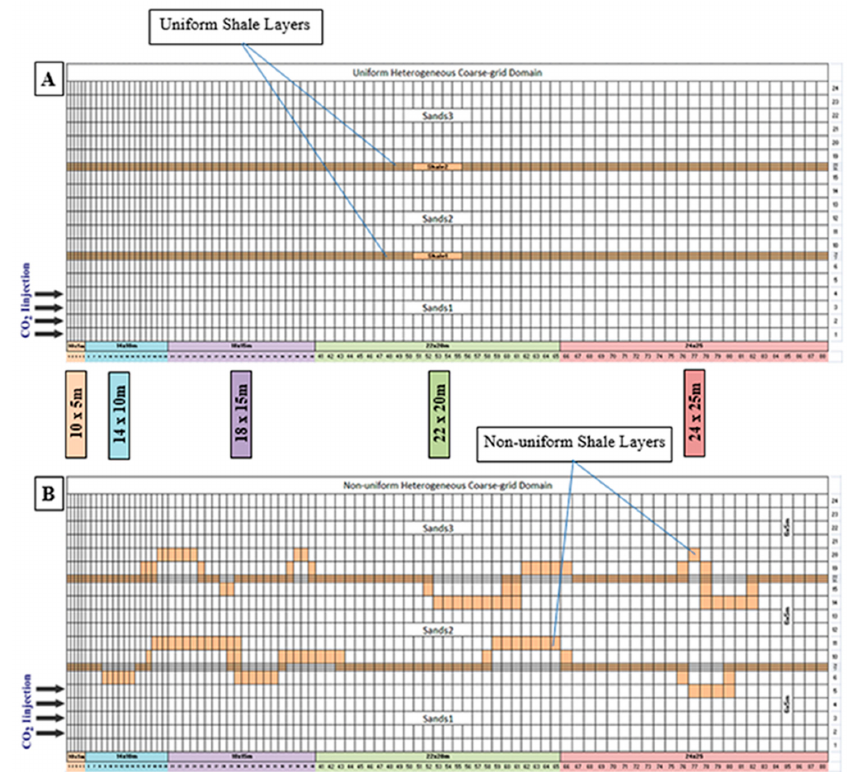
Figure 1. A schematic 2D diagram of the modelled heterogeneous domains: ( A ) uniform heterogeneity; ( B ) non ‐ uniform heterogeneity. ( B ) non-uniform